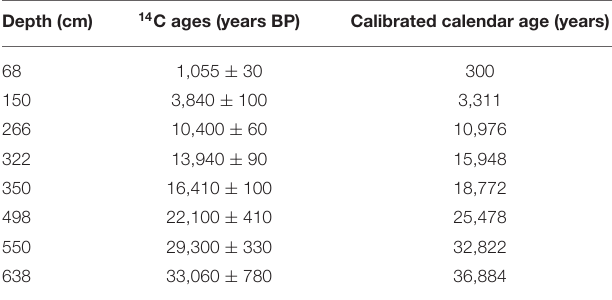
The AMS radiocarbon dates measured on monospecific samples of G. ruber were converted to calendar ages by using CALIB 6.0 software (Stuiver and Reimer, 1993) and considering a reservoir age of 400 years (Southon et al., 2002).